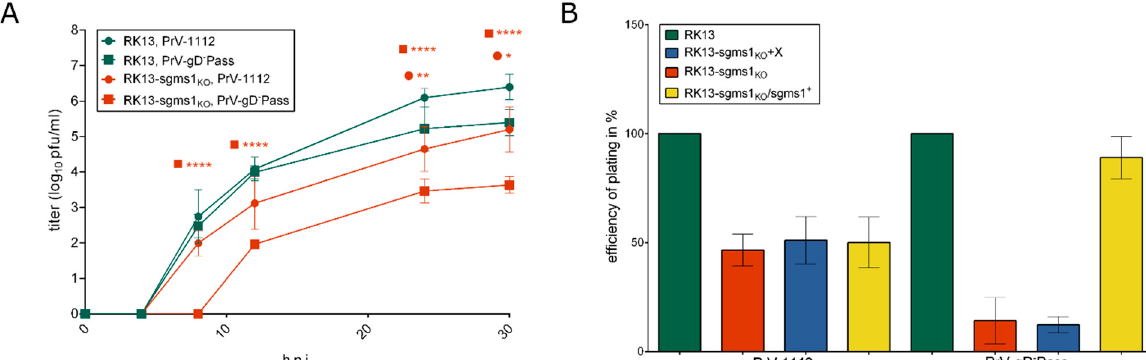
Figure 4. Effect of sgms1 gene knockout on PrV replication in RK13 cells. ( A ) RK13 and RK13-sgms1 KO cell lines were infected with PrV-1112 or PrV-gD – Pass at an MOI of 5 and harvested at different times p.i. Progeny virus titers were determined on RK13 cells. Given are mean values as log 10 plaque forming units (pfu) per ml of three independent experiments with corresponding standard deviations. Asterisks indicate statistically significant differences calculated by two-way ANOVA followed by Sidak’s multiple comparison test compared to the parental RK13 in the same symbol as the corresponding graph (* ≤ 0.05, ** ≤ 0.01, **** ≤ 0.0001). ( B ) For determination of the efficiency of plating (EOP) cells were infected with approx. 200 pfu per 12-well. The EOP was determined by counting plaques two days post infection and the numbers were normalized (in %) to parental RK13. Given are mean values of six independent experiments with corresponding standard deviations.